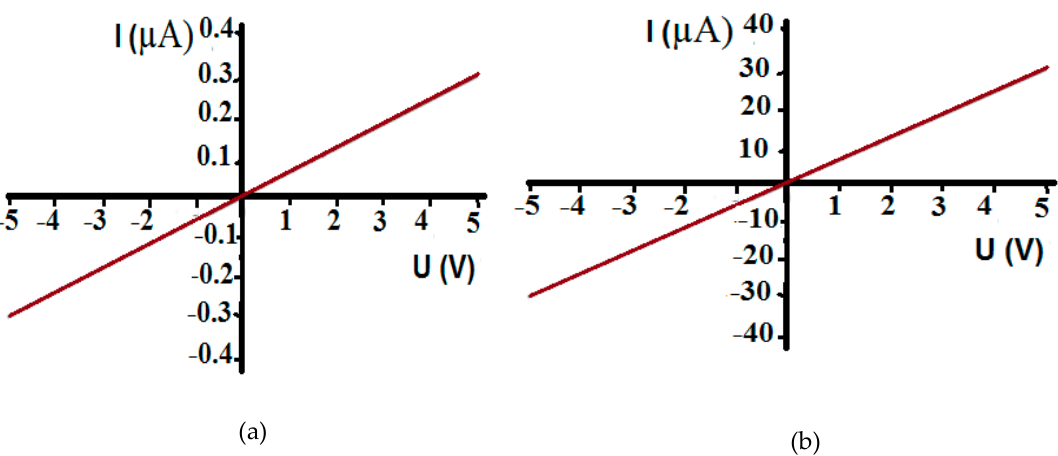
Figure 6. Current–voltage (I–V) curves of the gas sensor chips based on the silicon–carbon film, doped with Cu: ( a ) type-1 and ( b ) type-2 chips.